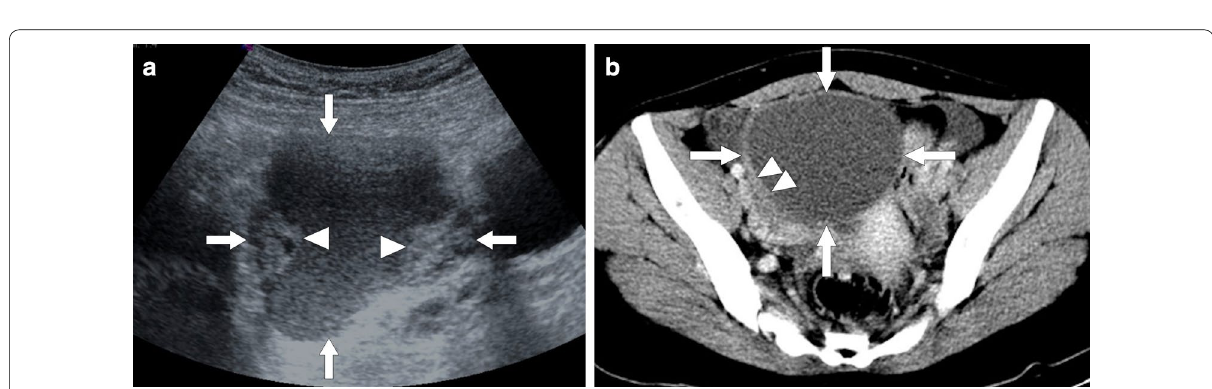
Fig. 28 Pelvic endometriosis. A 47-year-old woman with recent onset of pelvic pain and fullness. Gray scale US image a showed a large cystic mass (arrows) with solid-appearing mural nodules (arrowheads). There was no apparent blood flow on color Doppler imaging. Axial plane postcontrast CT image b shows the same cystic lesion (arrows) with asymmetrically thickened enhancing wall (approximately 45 HU) (arrowheads). Surgical resection confirmed endometrioma with no evidence of malignant